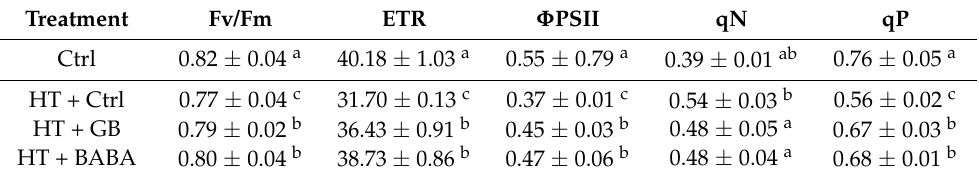
Table 2. Effects of GB and BABA on the chlorophyll fluorescence parameters under heat stress.